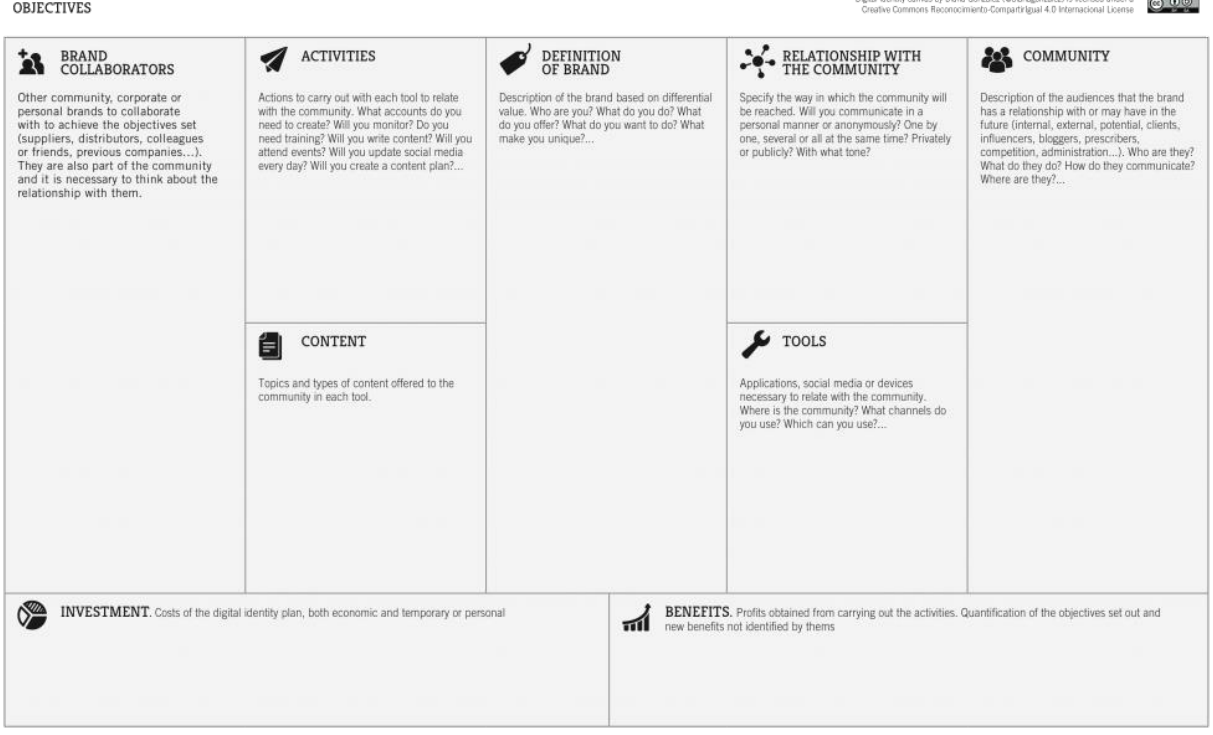
Figure 1. Personal identity canvas [23].